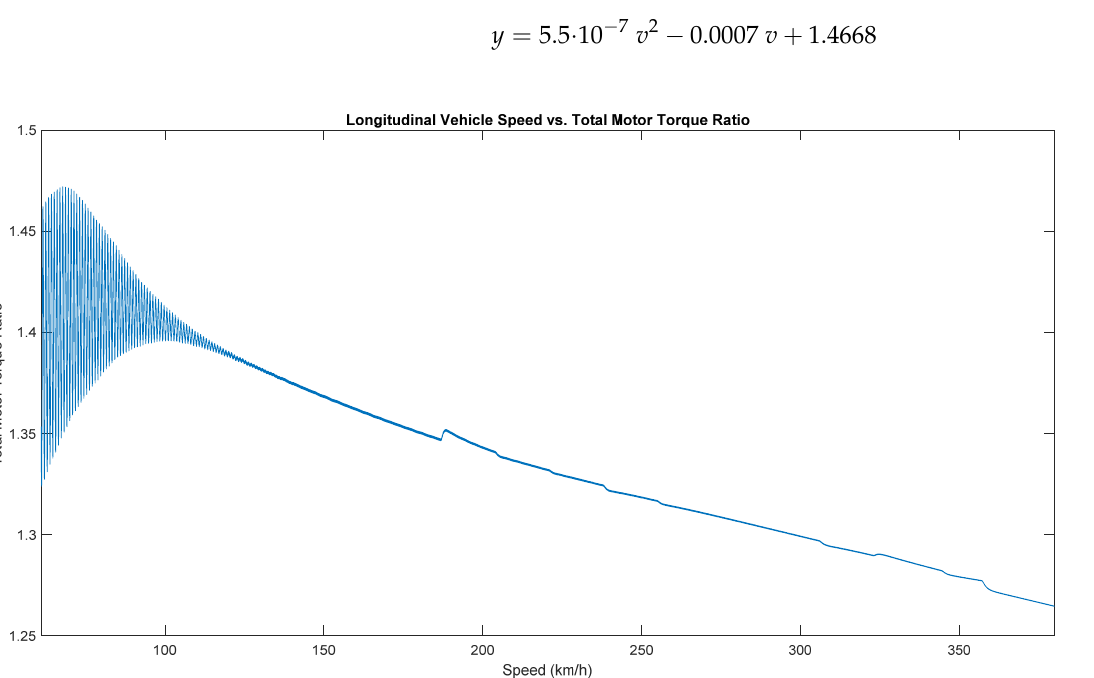
Figure 20. Second degree polynomial (in red) that approximate the ratio between the TEST and PROPS torques (in blue). 𝑦 = 5.5 ∙ 10 (cid:2879)(cid:2875) 𝑣 (cid:2870) − 0.0007 𝑣 + 1.4668 (51) The lower order coefficient of the squared speed indicates that the ratio between the torques has an approximately linear trend as a function of the speed, in particular the results of TEST and PROPS [8] tend to realign for high vehicle speeds. Equation (51) men- tioned above was then used to perform the TEST calibration for the hypercar described in Section 4.2. 4.2.7. Conditions for Validation of the Model